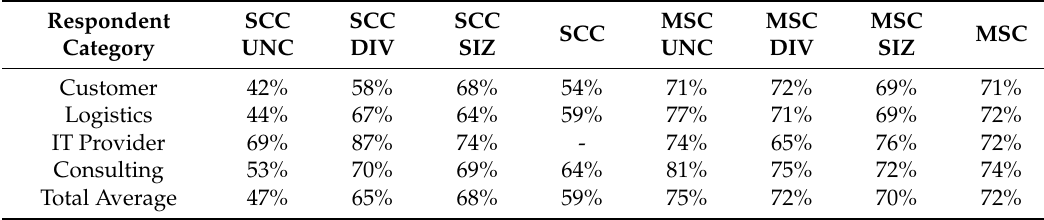
Table 5. Results concerning supply chain complexity and managing supply chain